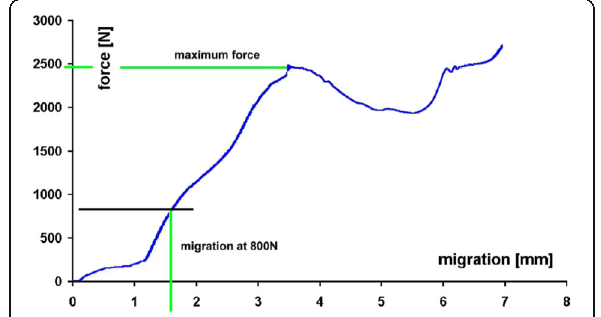
Fig. 4 Typical axial load-displacement curve of a MAC cage